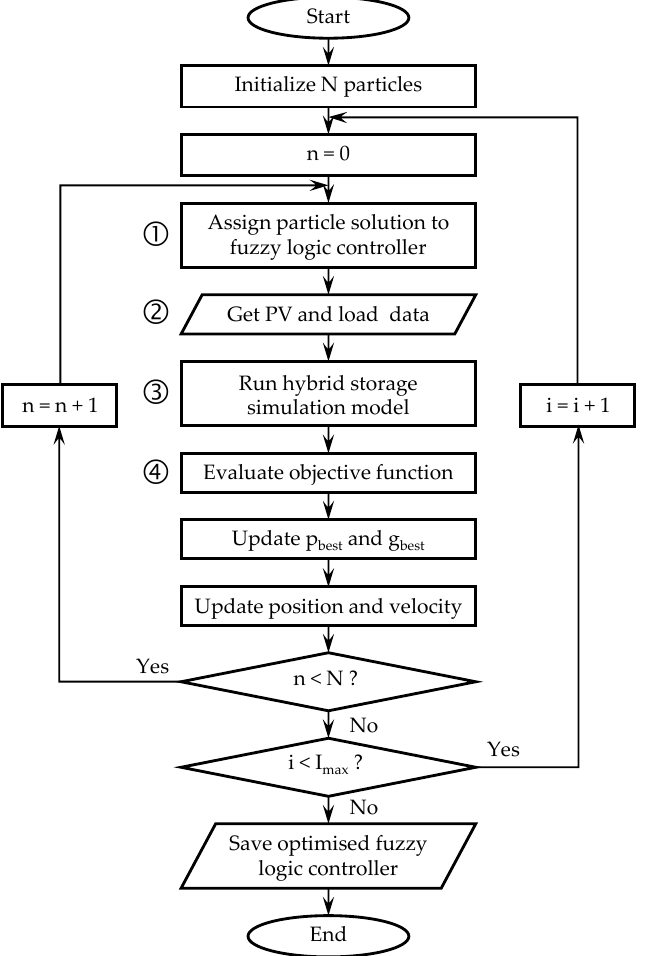
Figure 5. Flowchart of fuzzy logic controller tuning based on particle swarm